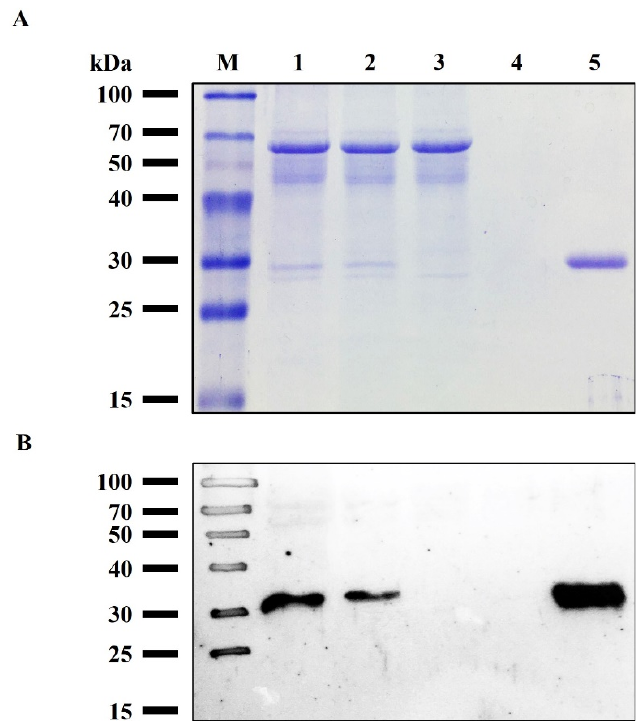
Figure 3. IMAC purification of rRBD. ( A ) SDS-PAGE analysis in the reducing condition of fraction collected during the purification process. ( B ) Western blot analysis of fraction collected during the purification process using anti-S antibody. Lanes: M, protein marker; 1, Sf9 cell expression supernatant; 2, diafiltrated sample (Input); 3, flow-through; 4, washing step (equilibration buffer with 80 mM imidazole); 5, IMAC fraction eluted by 500 mM imidazole.